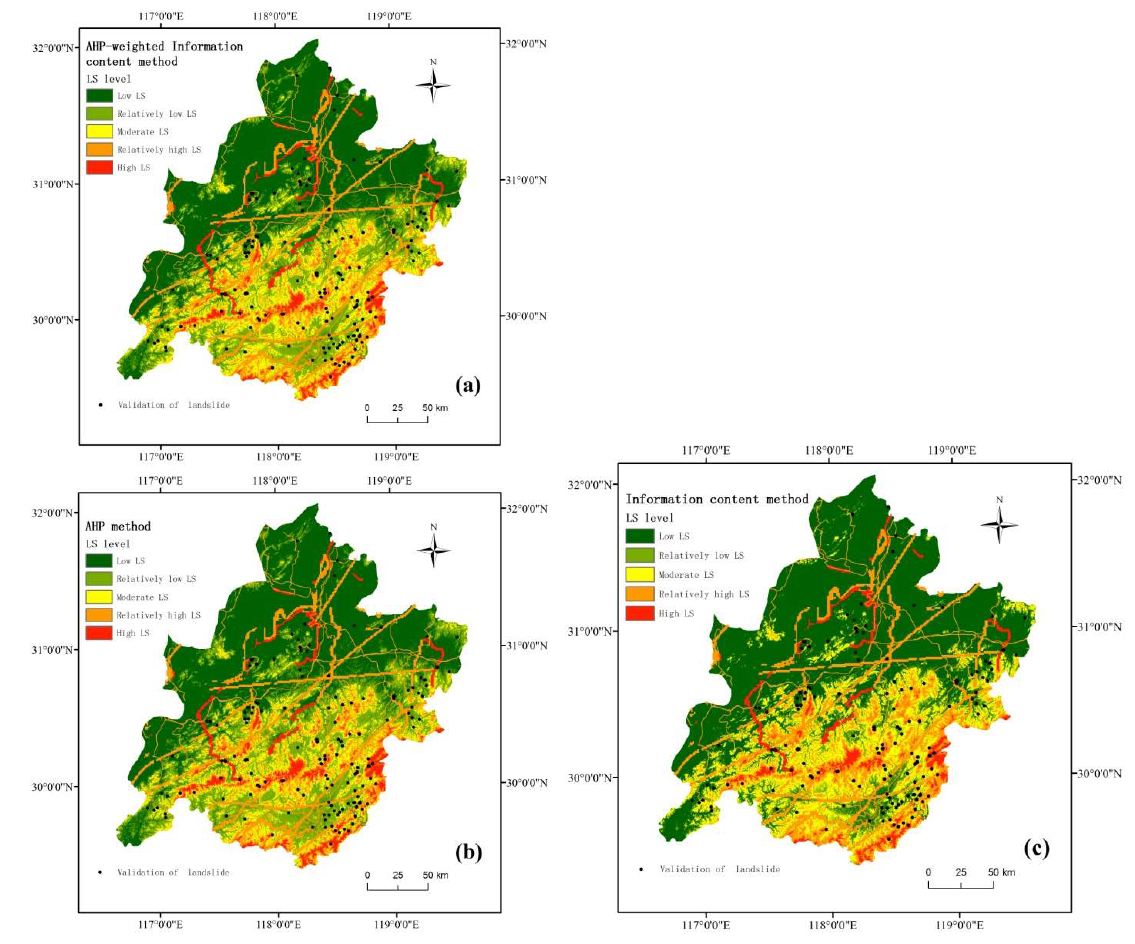
Figure 6. Validation of LS assessment of 212 randomly selected landslide sites for the validation models. ( a ) AHP-weighted information content method, ( b ) AHP method, ( c ) information content method.